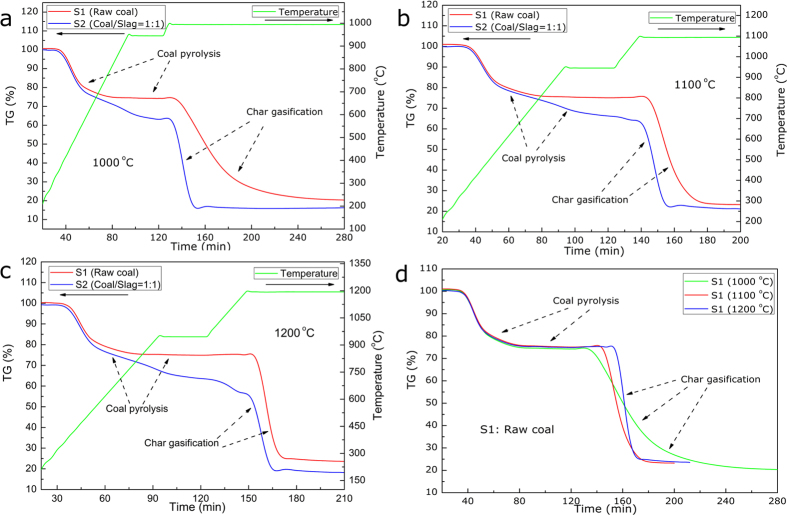
TG curves of the coal gasification process (a) TG curves at 1000 oC, (b) TG curves at 1100 oC, (c) TG curves at 1200 oC and (d) TG curves of the raw coal (S1) at 1000, 1100 and 1200 oC.